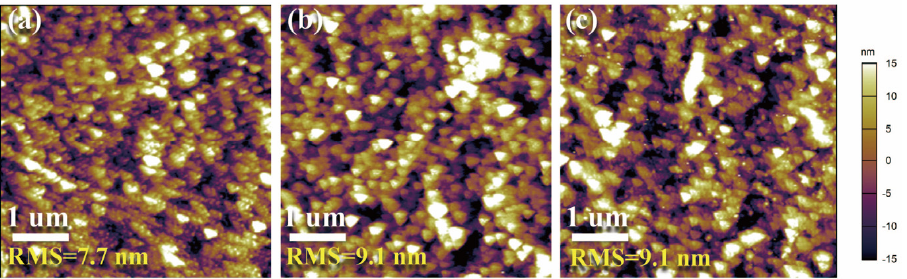
Figure 3. AFM images of MAPbBr 3 films on the substrate with ( a ) ITO, ( b ) ITO/PEDOT:PSS, and ( c ) ITO/PEDOT:PSS/TFB.